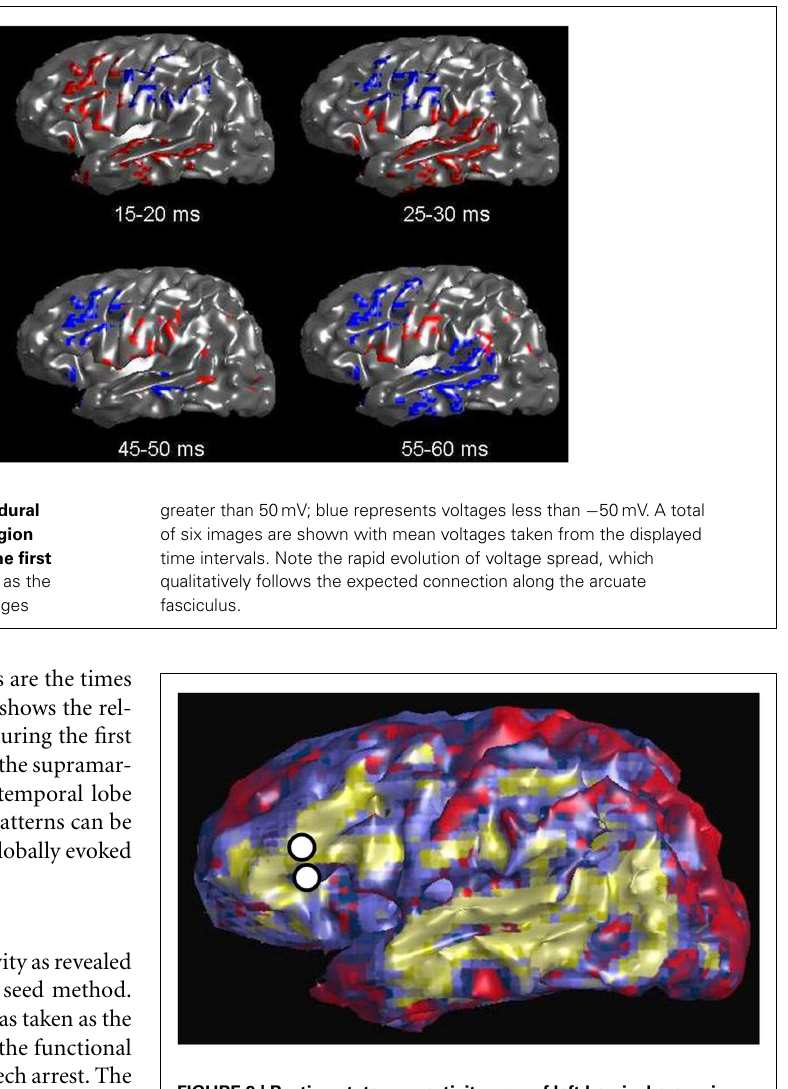
FIGURE 3 | Resting state connectivity map of left hemisphere, using seed-based approach with seed located at left Broca’s region as indicated by two white circles .These are the same locations used for CCEP stimulation in Figure 2 .The color scale reflects the value of the temporal correlation coefficient, with green-yellow representing any value greater than 0.5. Qualitatively there is strong correlation from Broca’s region to other expected language areas in the left temporal